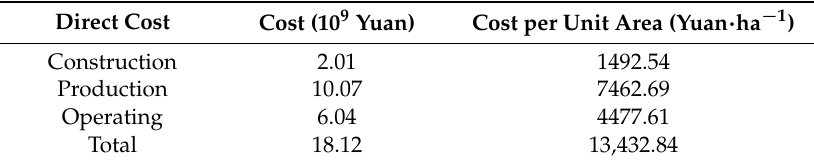
Table 5. Direct cost of public welfare forest in Yanqing District in 2014.